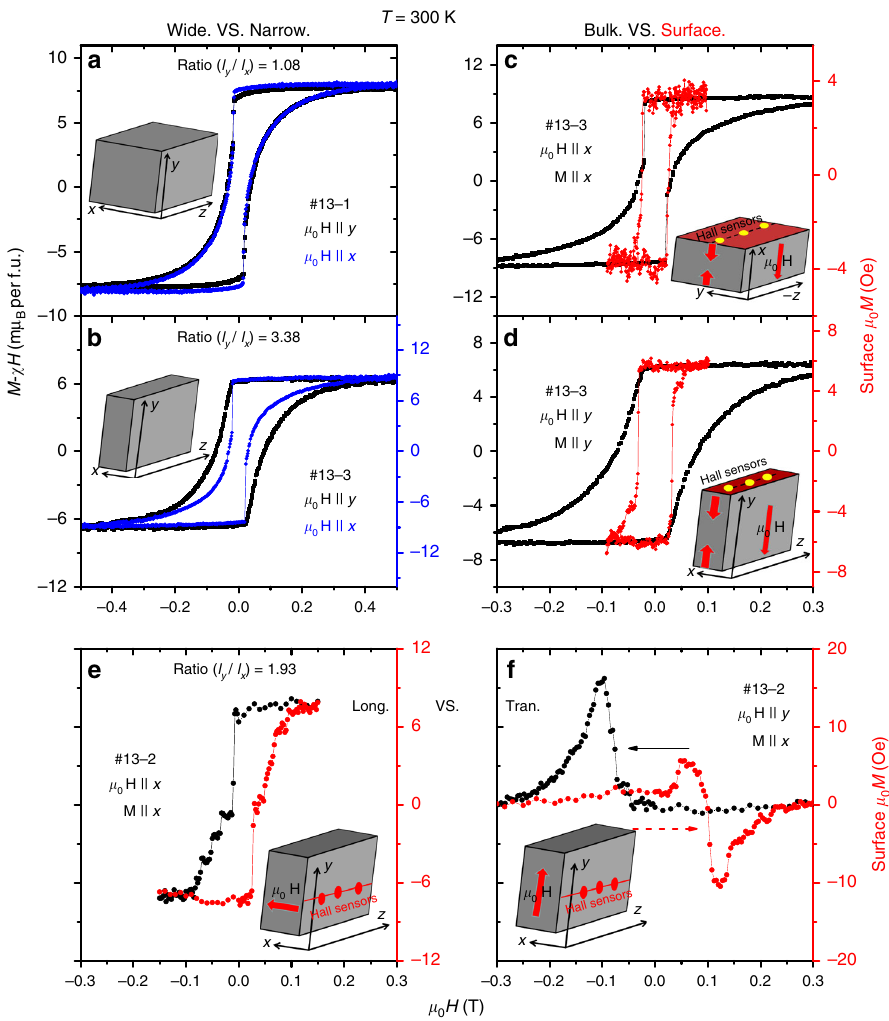
Fig. 2 Bulk and surface magnetization. a Bulk magnetization (after subtracting the high- fi eld slope) in a sample with an almost square cross-section ( l y / l x = 1.08) for two fi eld orientations. b Same in a sample where ( l y / l x = 3.38). The hysteresis loop is wider when the fi eld is oriented along the longer axis of the sample. c Bulk and surface magnetization in sample #13-3 for fi eld along x . d Bulk and surface magnetization in sample #13-3 for fi eld along y . In contrast to bulk magnetization, the hyteresis loop for surface magnetization is always narrow and does not depend on the aspect ratio. e Longitudinal surface magnetization coef fi cient μ 0 M xx ; f transverse surface magnetization coef fi cient μ 0 M yx in sample